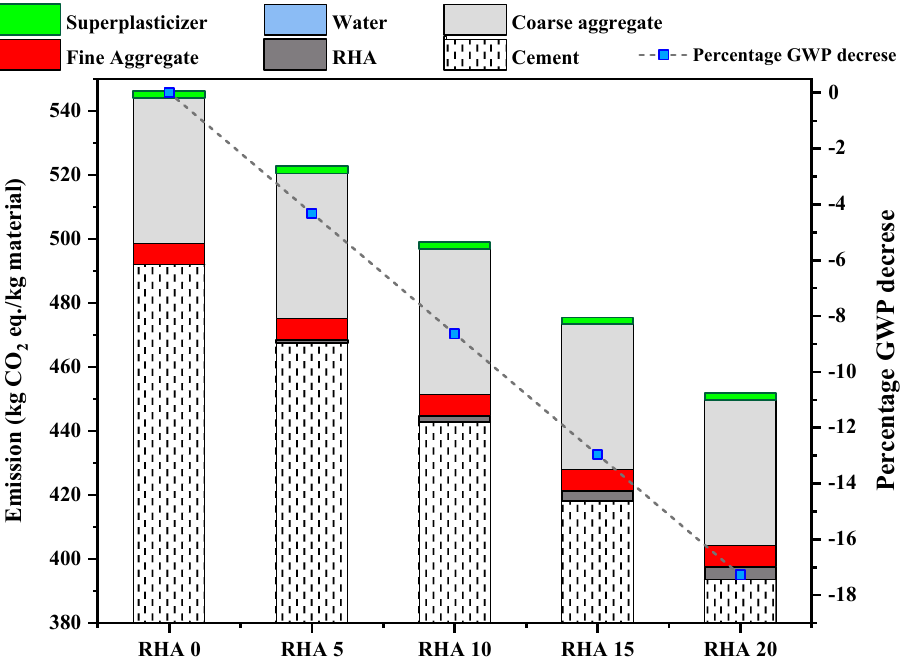
Figure 18. Total CO 2 emission and GWP enhancement percentage.